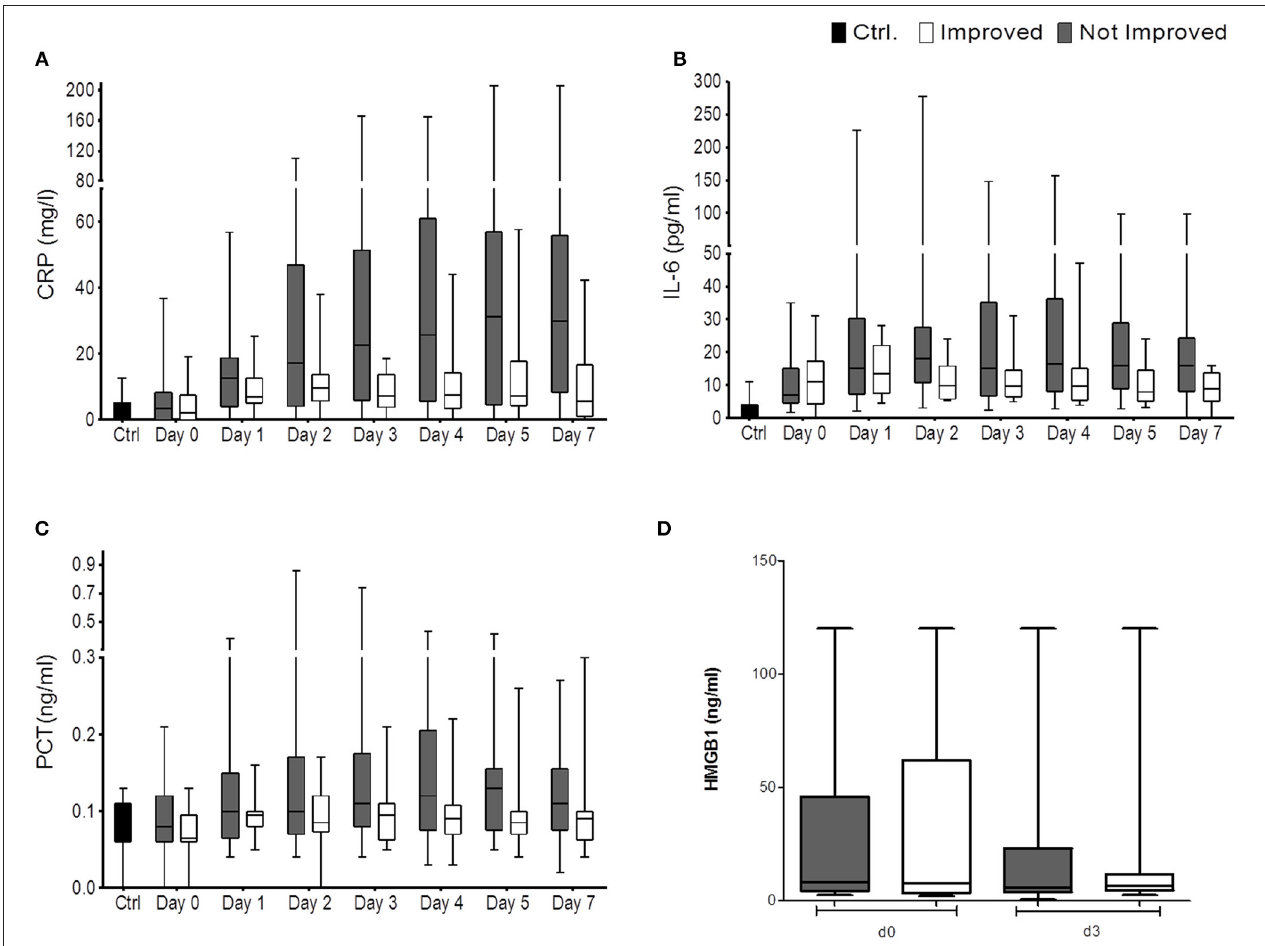
FIGURE 3 | CRP (mg/L) (A) , IL6 (pg/ml) (B) , PCT (ng/ml) (C) , and HMGB-1 (D) are shown for the comparison of improved patients (white bars) vs. non-improved patients (gray bars) on the day of stroke unit admission (day 0), days 1, 2, 3, 4, 5, 7 (n imp = 13, n non − imp = 27). HMGB-1 (in ng/ml) is shown for improved patients (white bars) and non-improved patients (gray bars) on the day of stroke unit admission (day 0) and day 3. Box and whiskers (Min–Max) are given (n imp = 11, n non − imp =